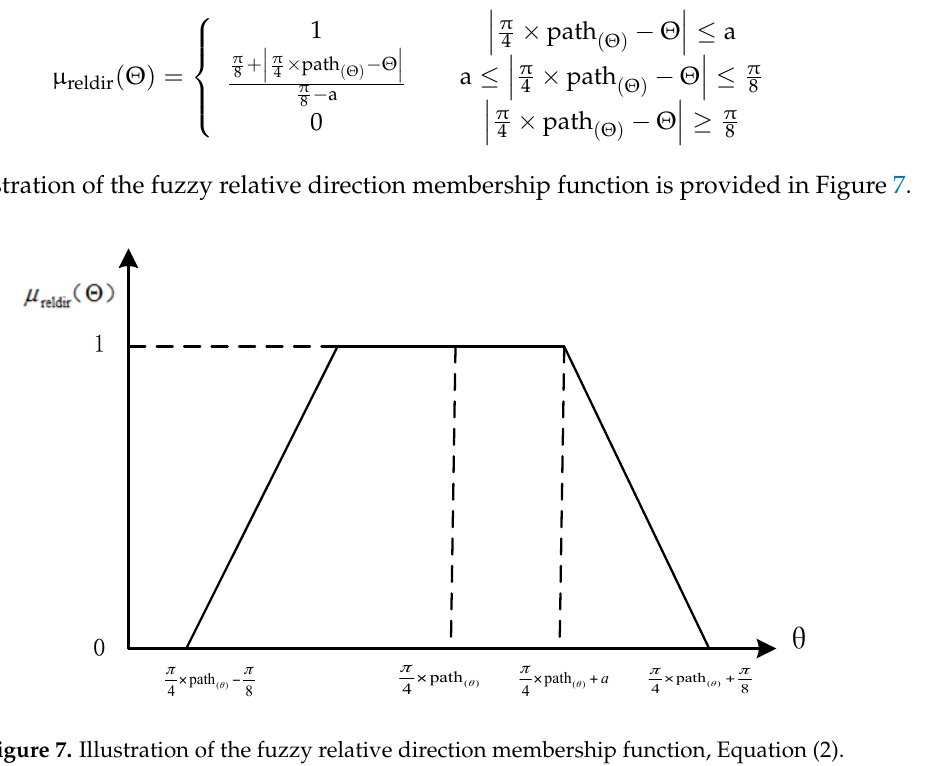
Figure 7. Illustration of the fuzzy relative direction membership function, Equation (2). As shown in Figure 8, path ( Θ ) in Equation (2) is the minimum path between the centerlines of corresponding cones. For example, from front to left, path ( Θ ) = 2. The visual field is divided into eight sectors, namely, “front, back, left, right, right front, right back, left front, and left back” or “north, south, west, east, northeast, northwest, southwest, and southeast”.